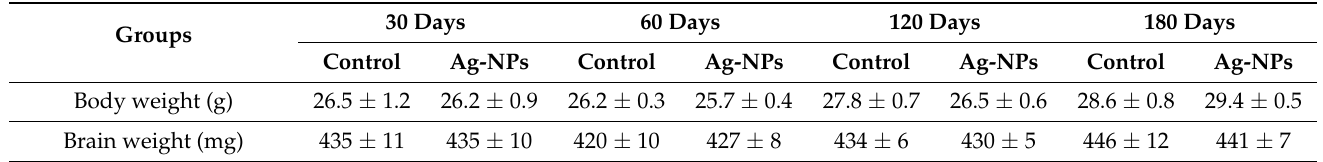
Table 1. Effects of Ag-NP exposure on the body and brains weight of the mice. Data represent the mean ± SEM. No significant differences were detected ( n = 6–8 animals in each